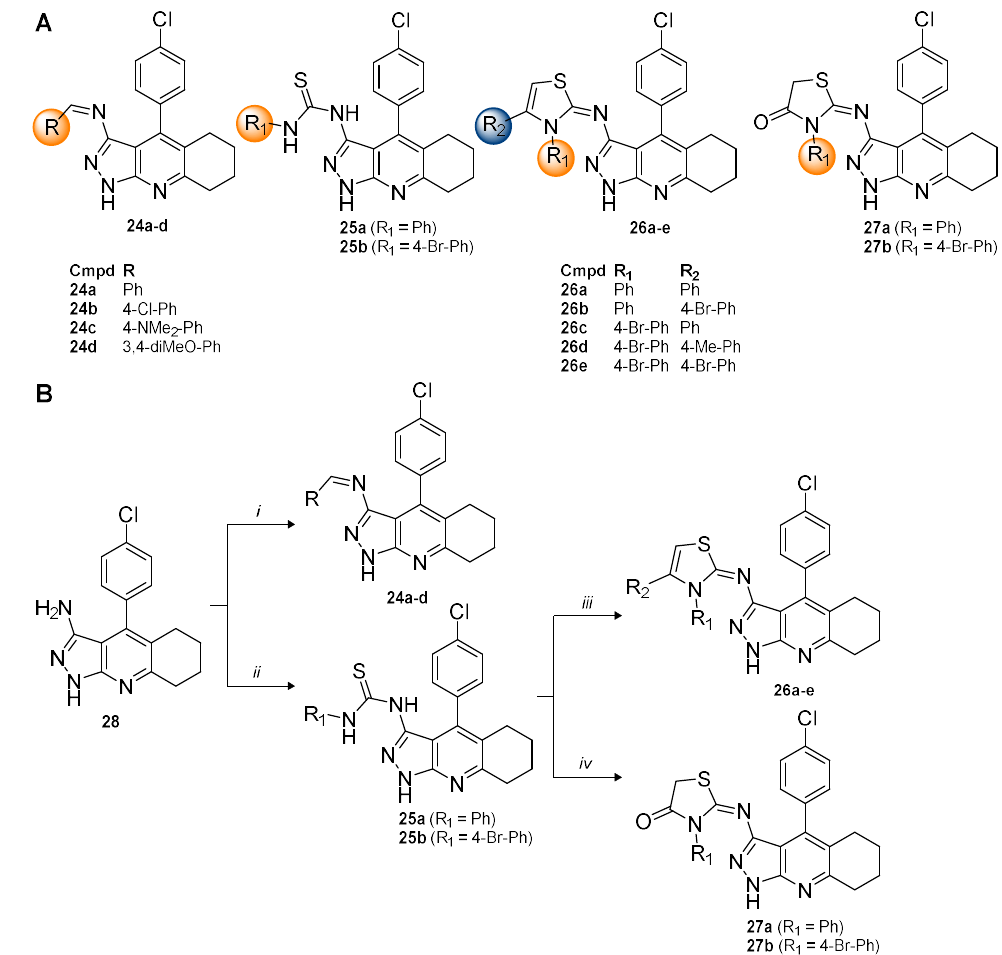
Scheme 7. ( A ) Structure of pyrazolotacrines 24a – d , 25a,b , 26a – e, and 27a,b [86]. ( B ) Synthesis of pyrazolotacrines 24a – d , 25a,b , 26a – e, and 27a,b . Reagents and conditions: ( i ) R-CHO, piperidine, EtOH, ∆ , 4 h, 80–90%; ( ii ) R 1 -NCS, EtOH, ∆ , 4–6 h, 83–89%; ( iii ) R 2 -COCH 2 Br, NaOAc, 1,4-dioxane, ∆